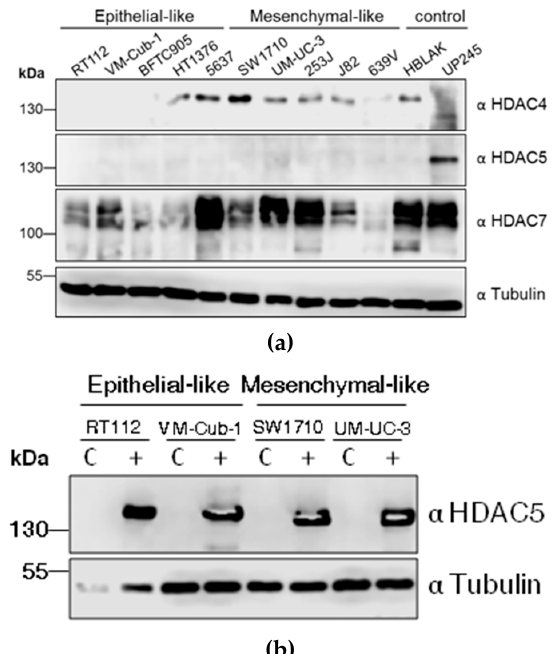
Figure 1. Class IIA histone deacetylases (HDAC) levels in UC cell lines (UCCs) and generation of HDAC5 stably-expressing cell lines. ( a ) Endogenous levels of HDAC4, HDAC5, and HDAC7 in the indicated UCCs and the urothelial controls HBLAK and UP245 as determined by immunoblotting of cell lysates. The description as “epithelial-like” or “mesenchymal-like” is based on morphology; see also Figure 5b. HDAC proteins were detected by the respective antibodies ( α ). α -Tubulin served as a loading control. ( b ) Analysis of HDAC5 overexpressing cell lines. Stably HDAC5-expressing cell lines were produced by lentivirus transduction. After selection for puromycin resistance, the cells were subjected to immunoblotting to confirm expression of HDAC5 protein. C: vector-only controls; + HDAC5-transduced cells.